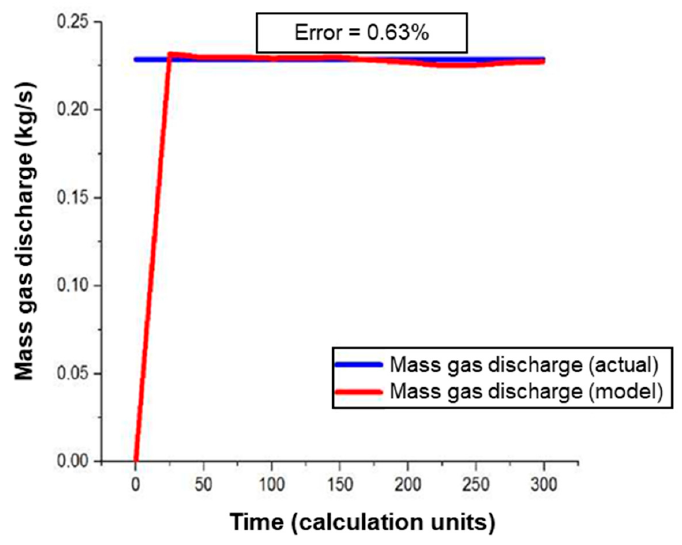
Figure 11. Adjustment of the model to actual values in the virtual flow meter